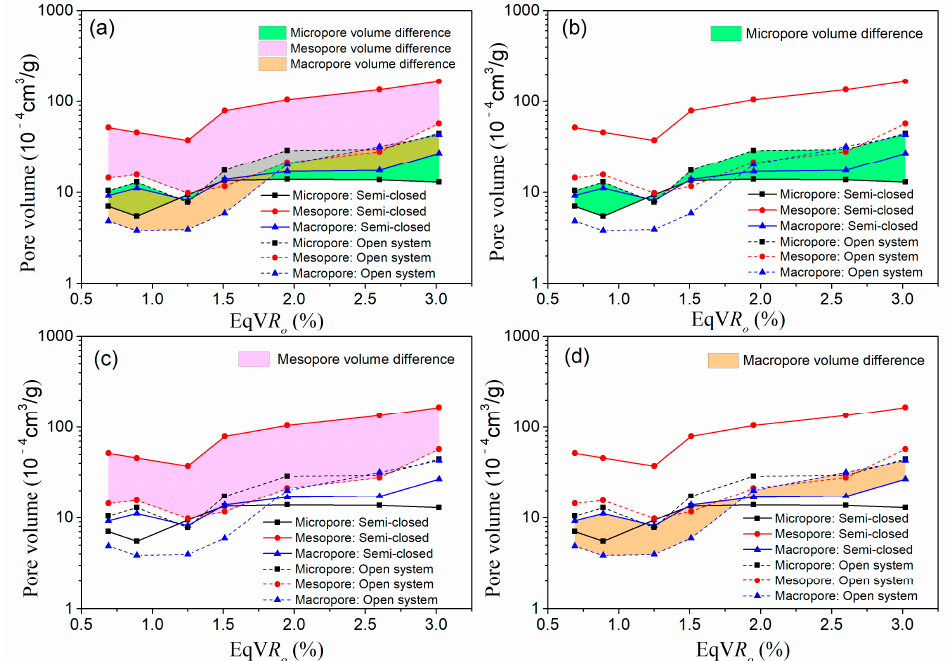
Figure 11. The difference in pore volume in the shale samples between the open and semi-closed system pyrolysis experiments. ( a ) Total comparison of pore volume; ( b ) micropore volume difference; ( c ) mesopore volume difference; ( d ) macropore volume difference. Data of semi-closed pyrolysis are cited from Fang et al.